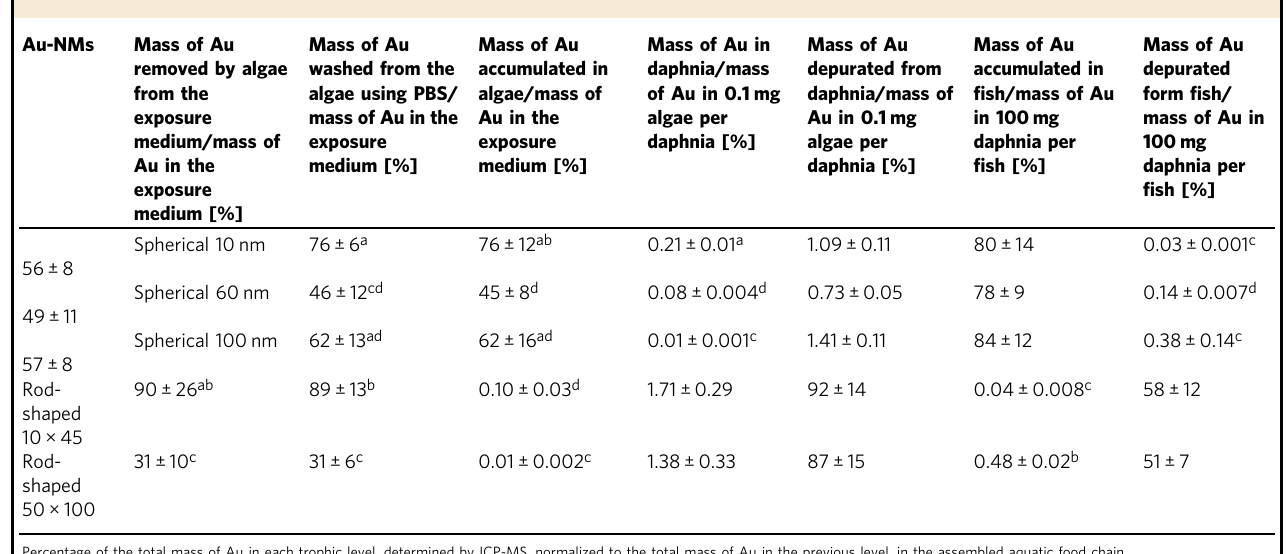
Table 1 Quanti fi cation of Au trophic